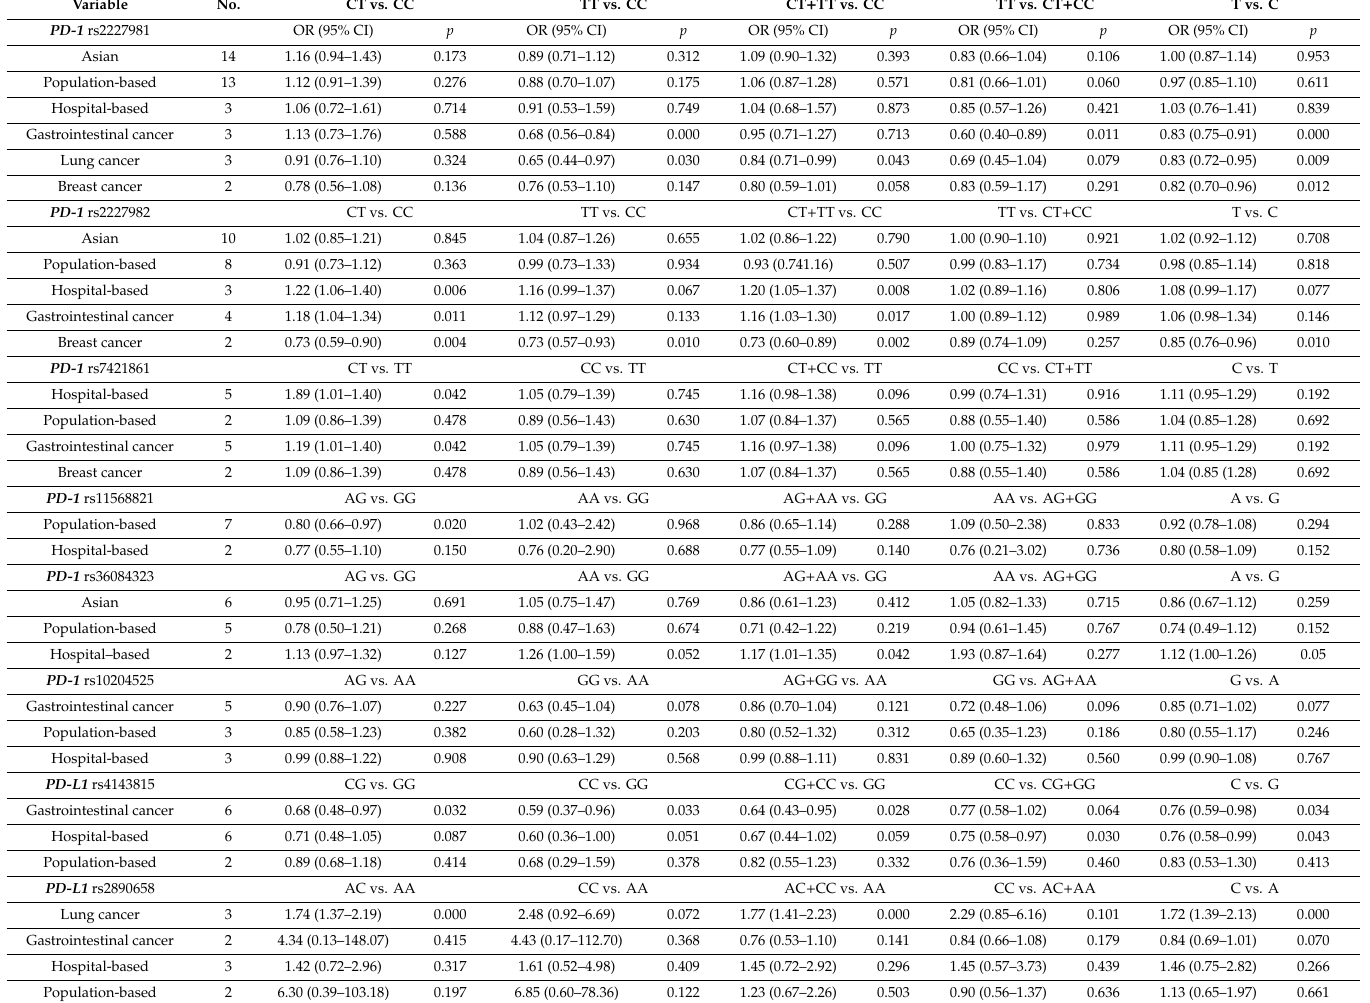
Table 4. Stratified analysis of PD-1 and PD-L1 polymorphisms with cancer